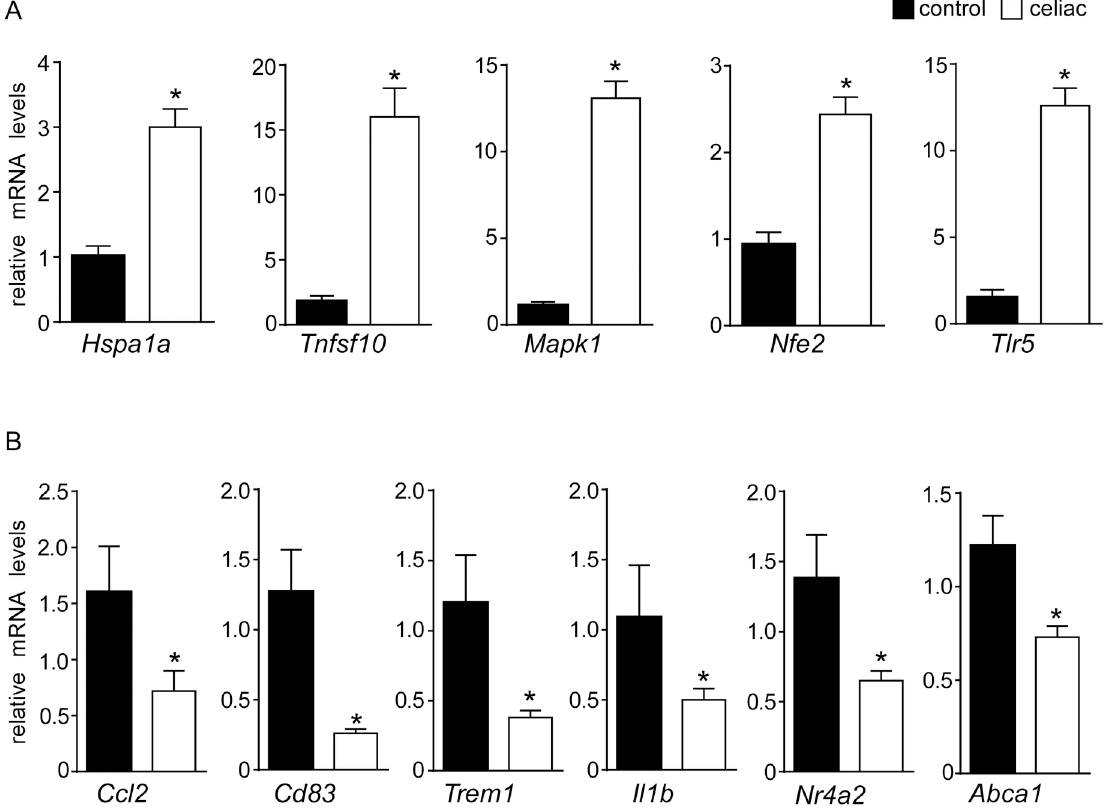
Fig 3. RT–qPCR confirmations : relative mRNA expression of (A) HSPA1a, TNFSF10, MAPK1, NFE2, TLR5; (B) ABCA1, CCL2, CD83, TREM1, IL1 β and NR4A2. Cyclophilin was used as reference gene, and values were normalized to data obtained from control patients. Data were plotted as fold change ± SEM ( (cid:3) = p (cid:20) 0.05).